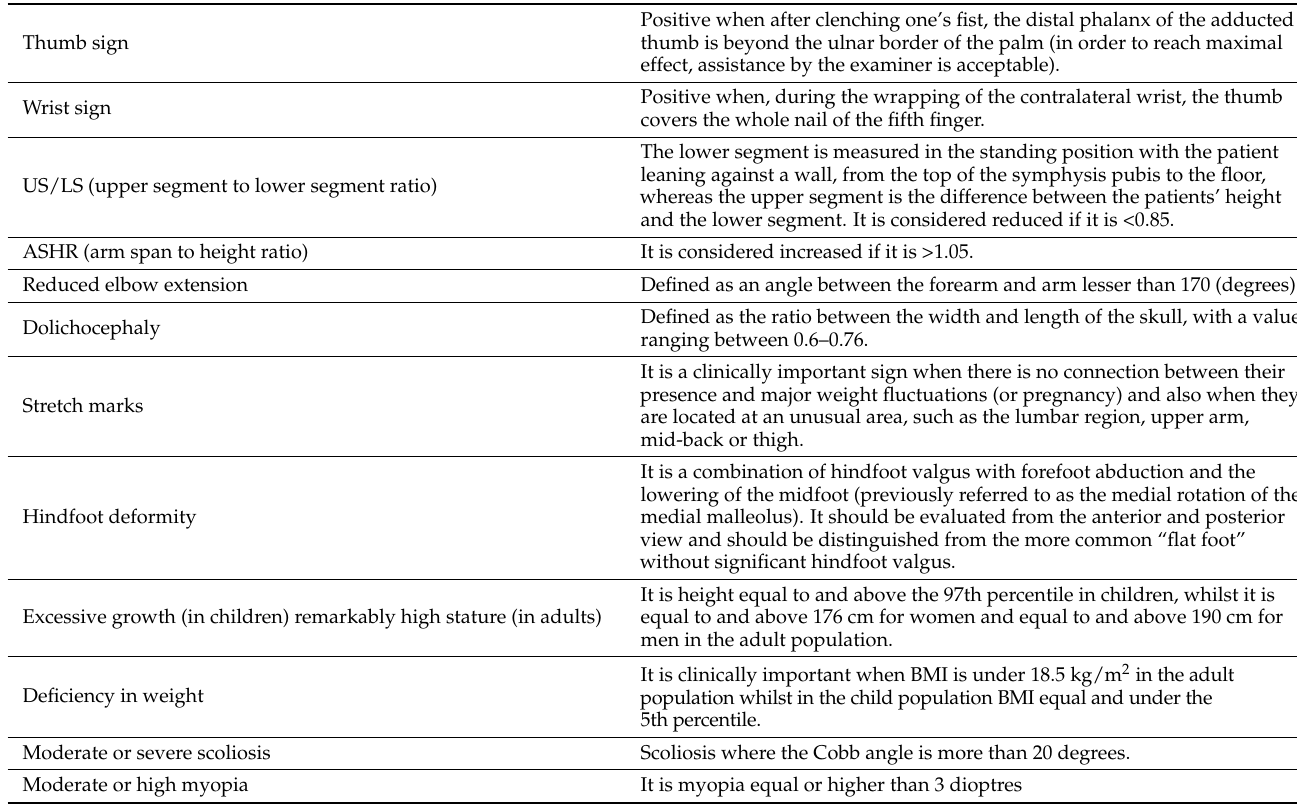
Table 1. Assessment methods of some of the parameters of the physical examination. Positive when after clenching one’s fist, the distal phalanx of the adducted Thumb sign thumb is beyond the ulnar border of the palm (in order to reach maximal effect, assistance by the examiner is